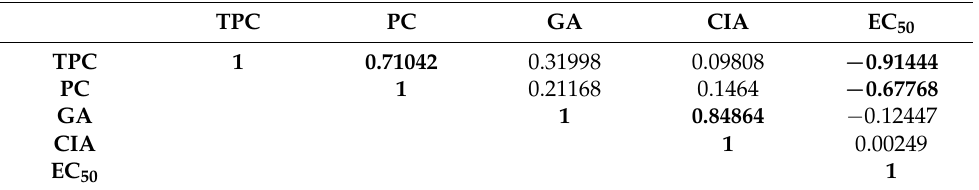
Figure 4. DPPH scavenging activity (expressed as EC 50 ) of the carob powder extracts obtained prior to (unroasted) and after roasting of kibbles at 125 ◦ C (for 15, 30, 45 and 60 min), 150 ◦ C (for 15, 30, 45 and 60 min) and 175 ◦ C (for 15, 30 and 45 min). The different letters show the statistically significant differences according to Tukey’s HSD test at p < 0.05. Table 2. Pearson correlation matrix among the total polyphenolic content (TPC), proanthocyanidin content (PC), gallic acid content (GA), cinnamic acid content (CIA) and antioxidant activity expressed as EC 50 values.